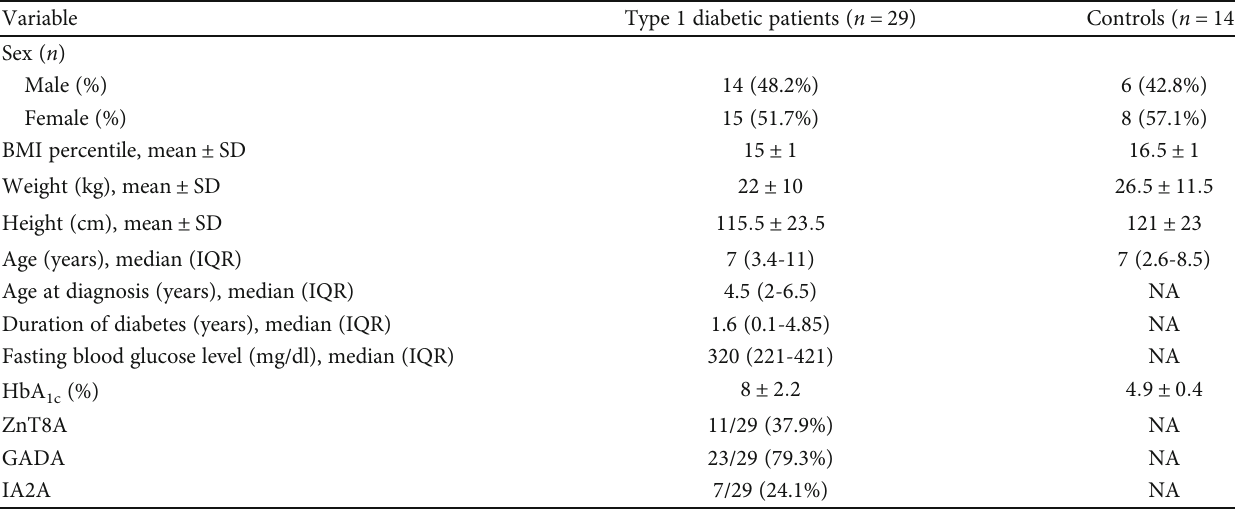
Figure 1: Gating strategy used to identify di ff erent peripheral B cell subsets. The initial CD19 + gate was derived from a lymphocyte gate (de fi ned on SSC and FSC) followed by dot plots gated on IL10 + CD19 + B cells showing the indicated B cell Table 1: Clinical and demographic features of study subjects ∗ .